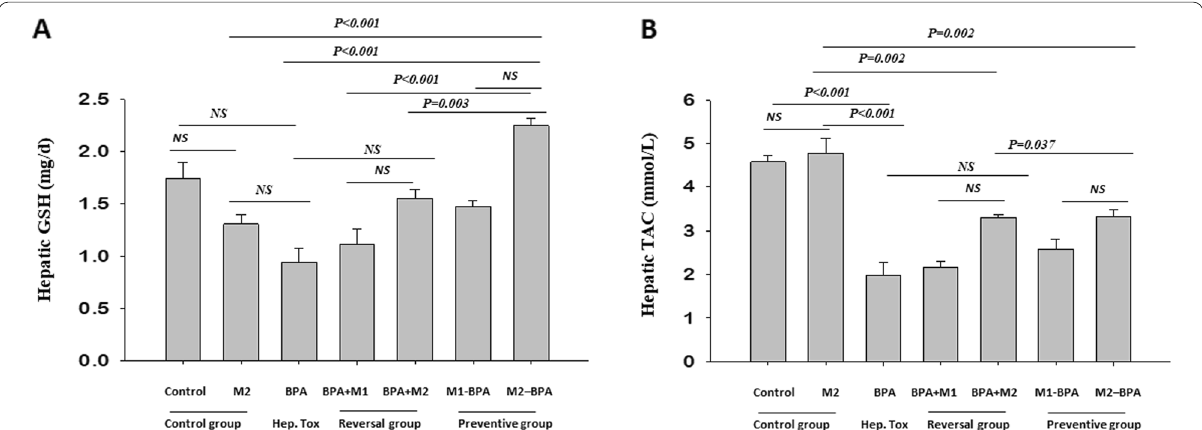
Fig. 3 Effect of Moringa oleifera on antioxidant activity of the liver tissue in BPA‑induced hepatotoxicity rats. Hepatic‑reduced glutathione (GSH, A ) and total antioxidant capacity (TAC, B ) levels were assessed in all groups. All data were presented as mean (50 mg/kg BW). M1 Moringa oleifera (200 mg/kg BW); M2 Moringa oleifera (400 mg/kg BW); P < 0.05 was considered significant. NS non‑significant, P >